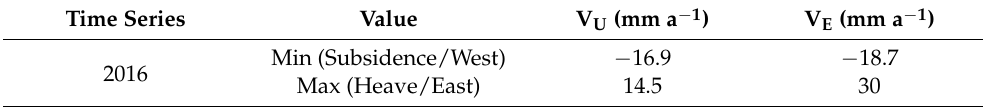
Figure 9. 2D E-W ground model spanning boreholes shown in Figure 8b to the west of Ventnor Park. Failure surface shown approximately 0 m OD dipping parallel with ground level in red is indicative; it is not known if this failure surface is planar or curviplanar. The mechanism consists of the overlying block of material sliding east along the failure surface in the Gault Clay/chalk debris, with the underlying block remaining static. Table 4. Summary of min and max vertical (V U ) and horizontal (V E ) in Ventnor during